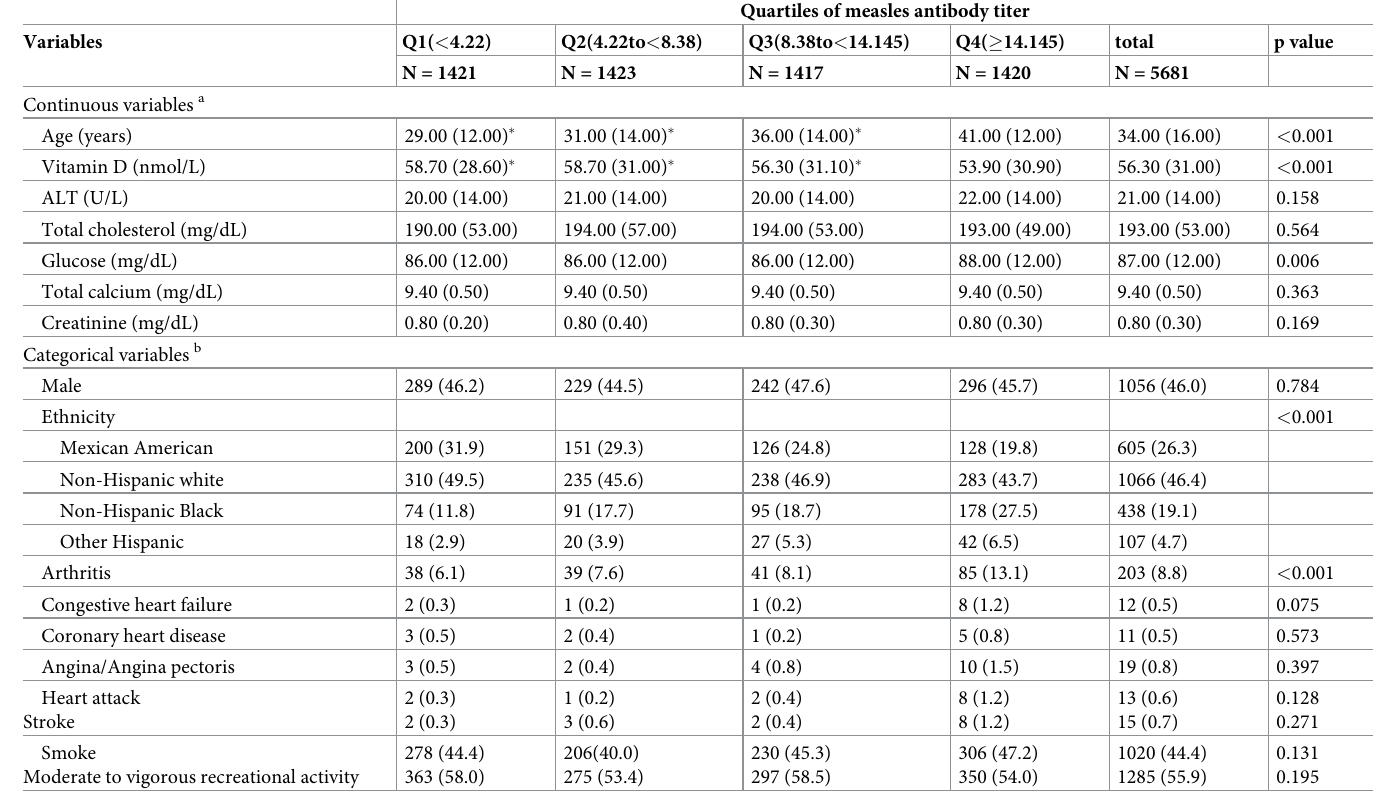
Table 1. Characteristics of study participants.